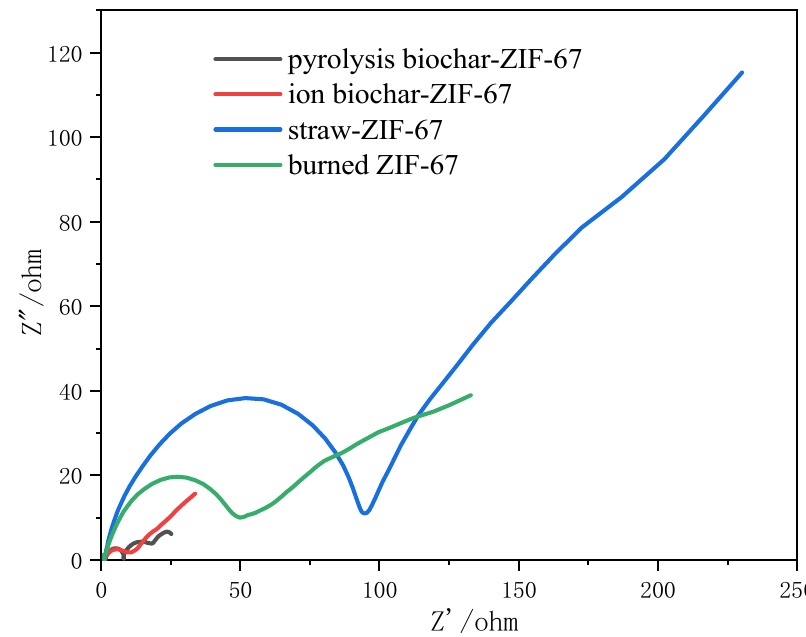
Figure 5. AC impedance diagrams for different materials.